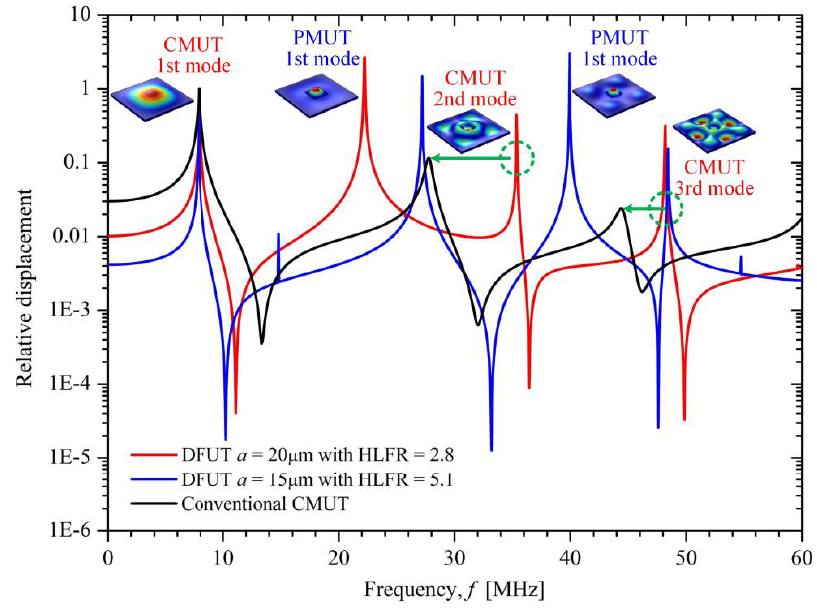
Figure 8. Simulated frequency response for the single-element DFUT and one conventional CMUT.